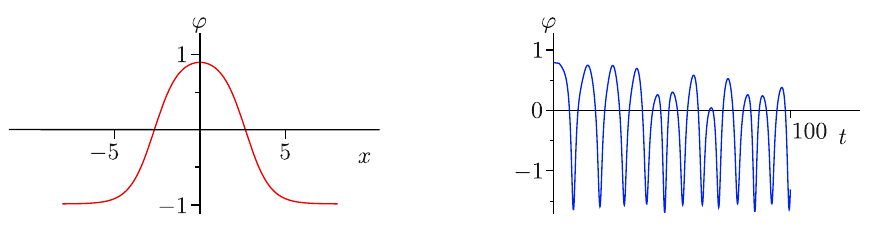
Figure 5.1: The field ϕ ( t , x ) obtained by gluing together half a kink, half a period of an elliptic sine, and half an antikink. Both the spatial profile at t = 0 (left panel), and the its time evolutions (shown at x = 0 in the right panel) closely approximate that of the quasi-long-lived bion. For these figures, the parameter values ϕ and δϕ = − 0.001 were